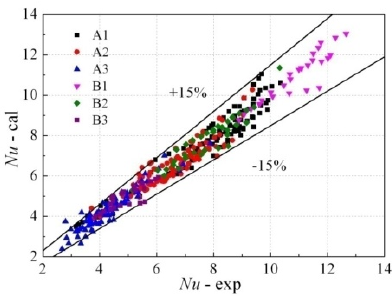
Figure 18. Comparison of calculated data with experimental data.